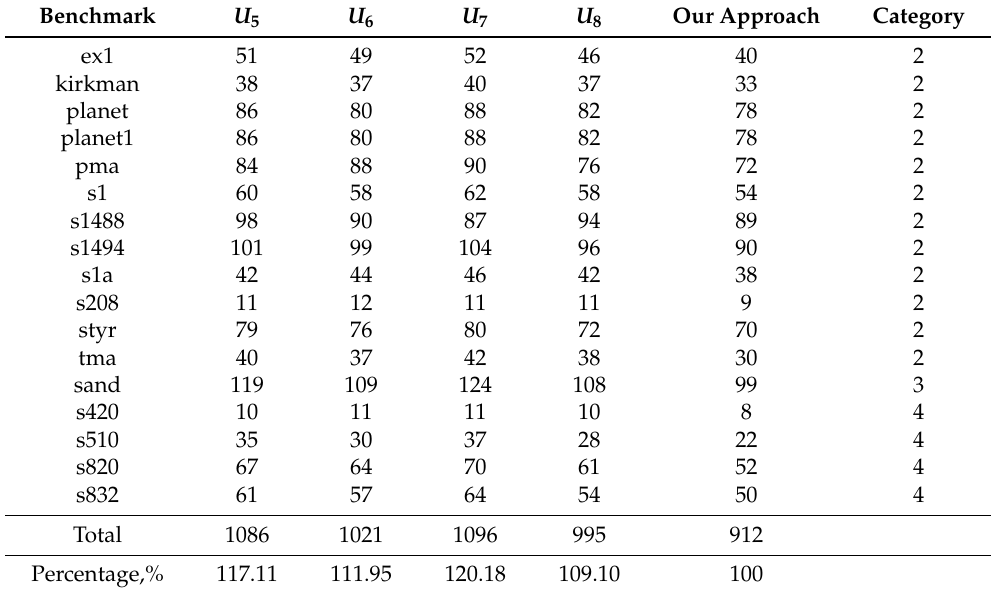
Table 10. Comparison of our approach with two-level